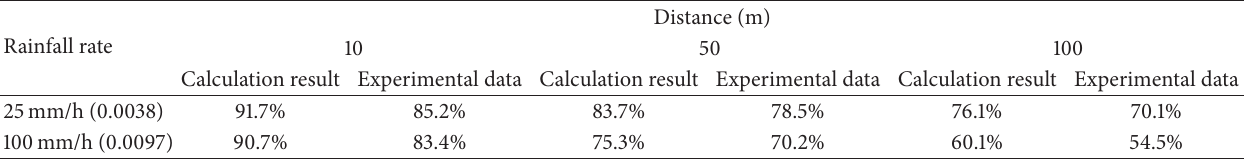
Table 3: Numerical and measured data of laser pulse propagating in rain for various distances. Rainfall rate